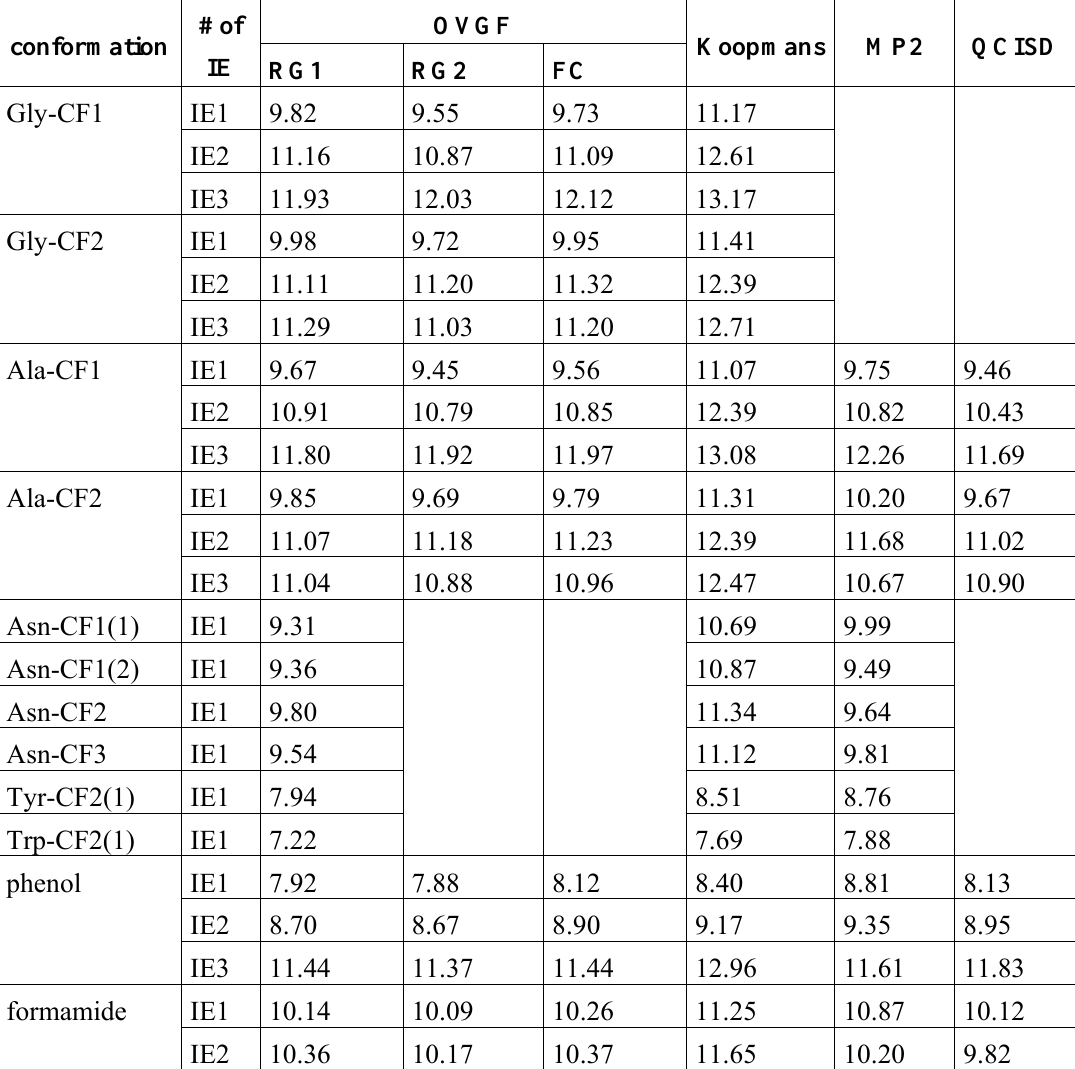
Table 2: Vertical ionization energies IE (eV) calculated with the OVGF method for one or several conformations of Gly, Ala, Asn, Tyr and Trp, as well as for phenol and formamide. The number of virtual orbitals included in two of the OVGF calculations varied as a multiple n of the number of occupied valence ones: RG1: n=1; RG2: n=2. The third OVGF calculation was performed at the frozen core (FC) level. The results are compared with MP2(FC) and QCISD(FC) IEs. The ordering of the IEs relies on the MO ionized, from the highest (HOMO)